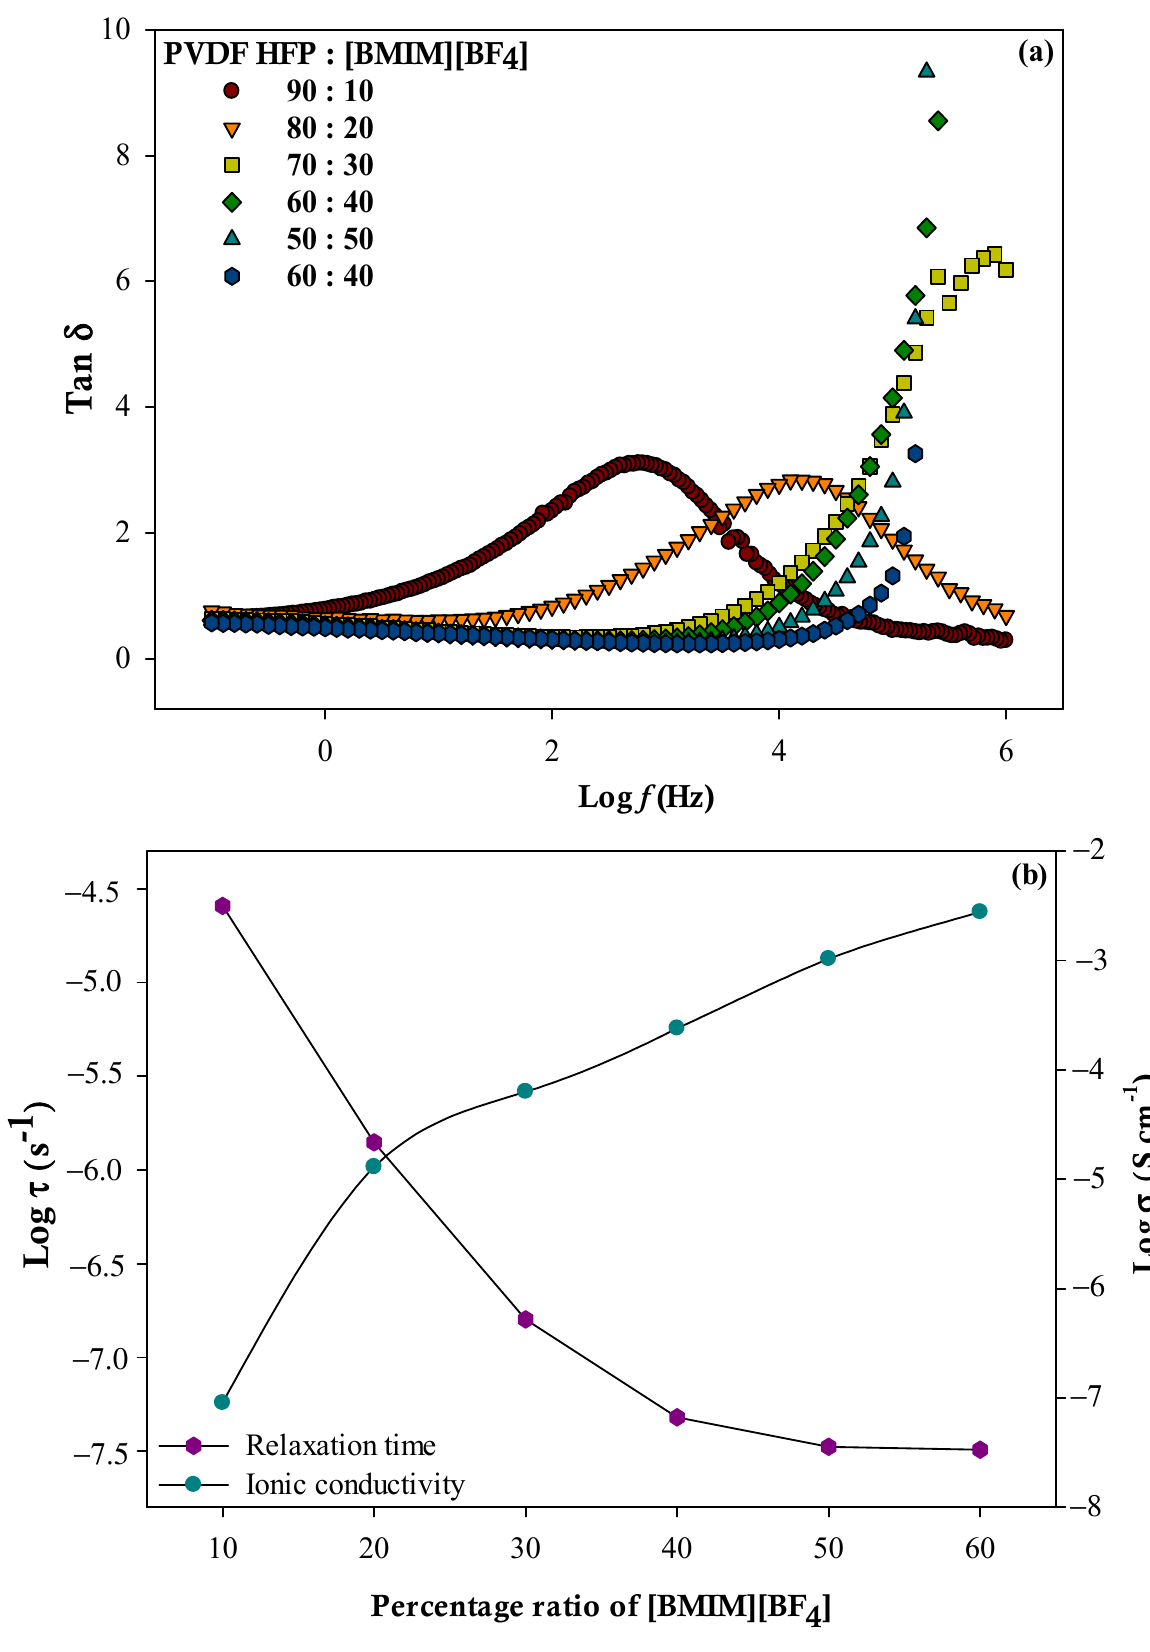
Figure 5. ( a ) Frequency dependence of tan δ and ( b ) relation between relaxation time and ionic conductivity for different percentage ratios of PVDF-HFP to [BMIM][BF 4